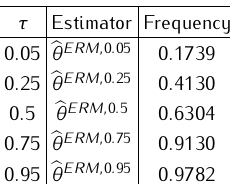
Table 2. Empirical frequencies of the event: GDP falls under the predicted